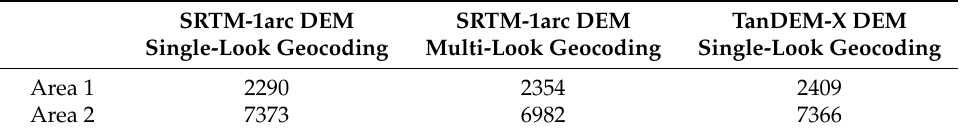
Figure 15. Height value of the selected PSs of two selected areas in map coordinate: ( a – c ) Area 1 locates at SZCEC; and ( d – f ) Area 2 locates around Futian Port. The background is the optical image derived from Googleearth. ( a , d ) The elevation and distribution of selected PS with SRTM-1arc DEM Table 3. PS numbers of the two selected area with two different external DEMs. in multi-look geocoding operation. ( b , e ) The elevation and distribution of selected PS with SRTM-1arc DEM in single-look geocoding operation. ( c , f ) The elevation and distribution of selected PS with TanDEM-X DEM in single-look geocoding operation. The dashed lines in ( a ) represent the regular building structures, i.e., cross girder. The red lines in ( d – f ) represent the linear feature, i.e., bridges.